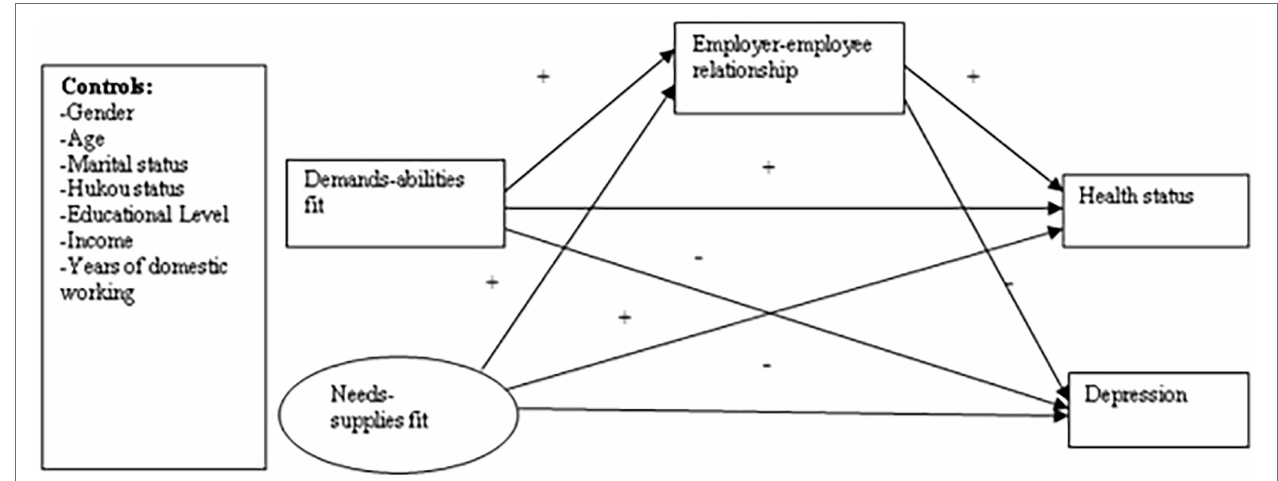
FIGURE 1 | Hypothesized process model.